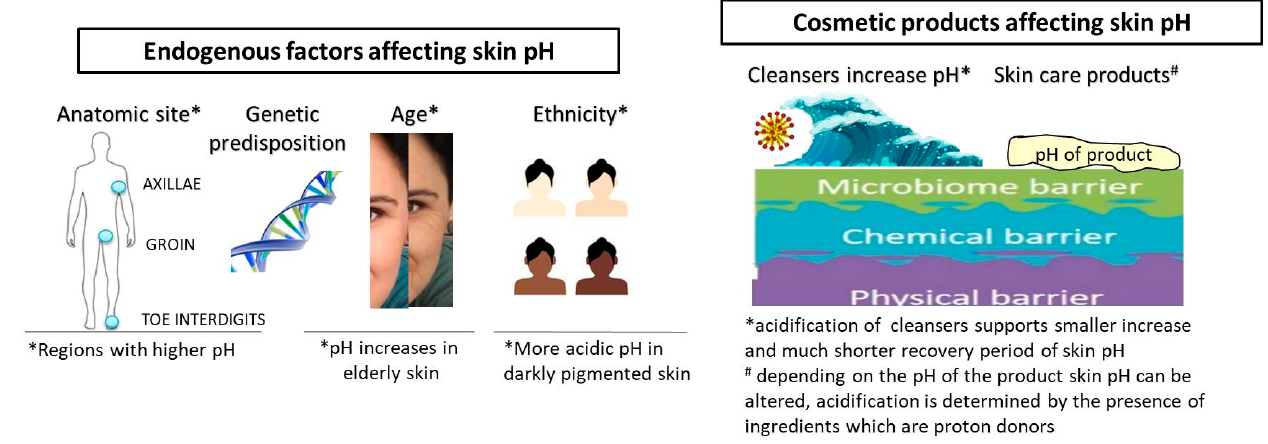
Figure 1. Endogenous and exogenous factors affecting skin pH .